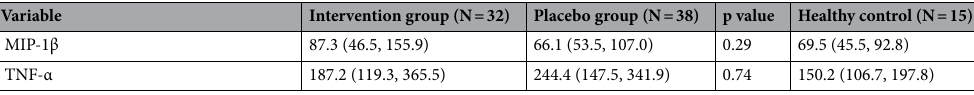
Table 1. Baseline characteristics and plasma cytokine concentrations at enrollment for the intervention group, placebo group on study Day 1, and healthy controls. All cytokine levels were calculated based on mean fluorescent intensity and reported in pg/mL and are reported as medians (Interquartile range). p values for the comparisons between the intervention group and healthy controls and between placebo group and healthy controls are reported in Figure S2. For categorical variables, chi-square test was used to calculate p values except for p values labeled with ^^ indicating the use of Fisher exact test. For continuous variables, Mann–Whitney U test was used to calculate p value except for p values labeled with * indicating the use of t test. APACHE II: Acute Physiology and Chronic Health Evaluation II, SOFA: Sequential Organ Failure Assessment score, ICU = intensive care unit, IQR interquartile range. G-CSF: granulocyte-colony stimulating factor; GM-CSF: granulocyte–macrophage colony-stimulating factor; IFN: interferon; IL: interleukin; MCP: Monocyte chemo-attractant protein; MIP: Macrophage inflammatory protein; TNF: tumor necrosis factor. † The body mass index is the weight in kilograms divided by the square of the height in meters. ‡ Scores on the Acute Physiology and Chronic Health Evaluation (APACHE) II range from 0 to 71, with higher scores indicating more severe disease and higher risk of death.